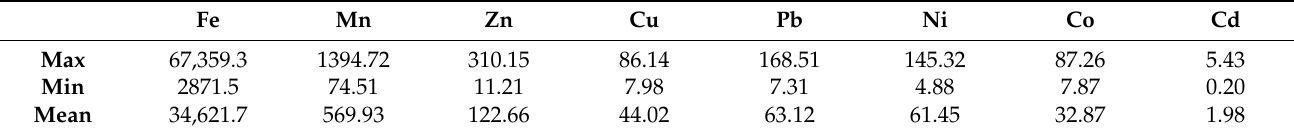
Table 3. Maximum (max), minimum (min), and mean values of total heavy metals